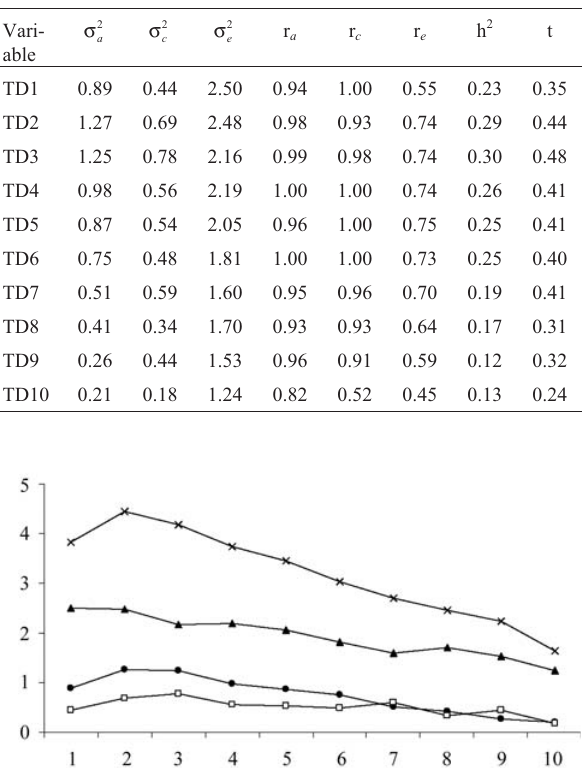
Table 3 - Estimates of additive genetic ( σ ( σ peatability (t), genetic (r a ), permanent (r c ) and temporary environmental (r